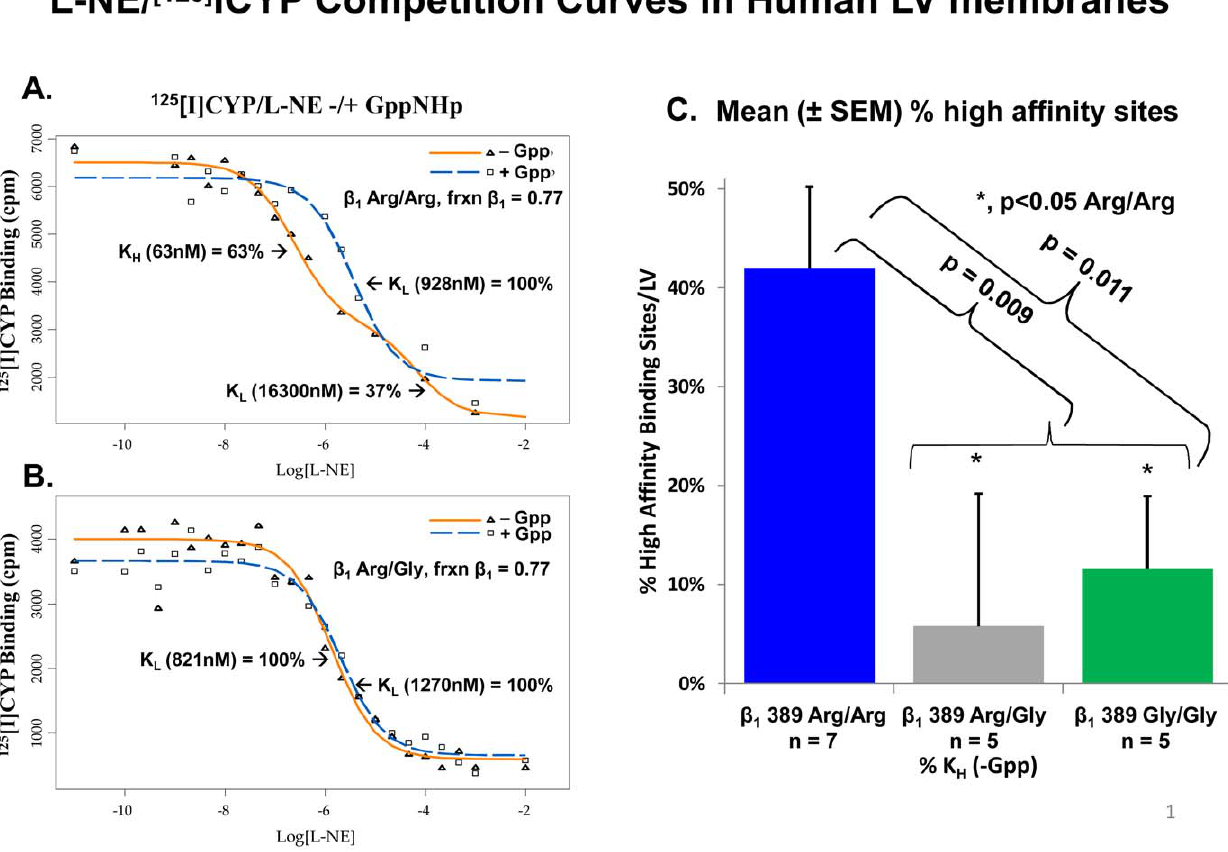
Figure 2. Representative competition curves between 50 pM 125 [I]CYP and L-NE at increasing concentrations, in the absence and presence of 30 m M Gpp(NH)p in membranes from a non-failing human left ventricle with 77% b 1 AR that was b 1 389 Arg/Arg genotype (A) and in membranes from a non-failing human heart with 77% b 1 AR that was b 1 389 Arg/Gly genotype (B); mean ± SEM (%) of high-affinity L-NE binding sites identified in seven b 1 389 Arg/Arg, five b 1 389 Arg/Gly, and five b 1 389 Gly/Gly left ventricles (C). Abbreviations: AR, adrenergic receptor; CYP, cyanopindolol; Gpp(NH)p, non-hydrolyzable guanine nucleotide; K H , dissociation constant; K L , low- affinity binding constant; L-NE, L-norepinephrine; SEM, standard error measurement.